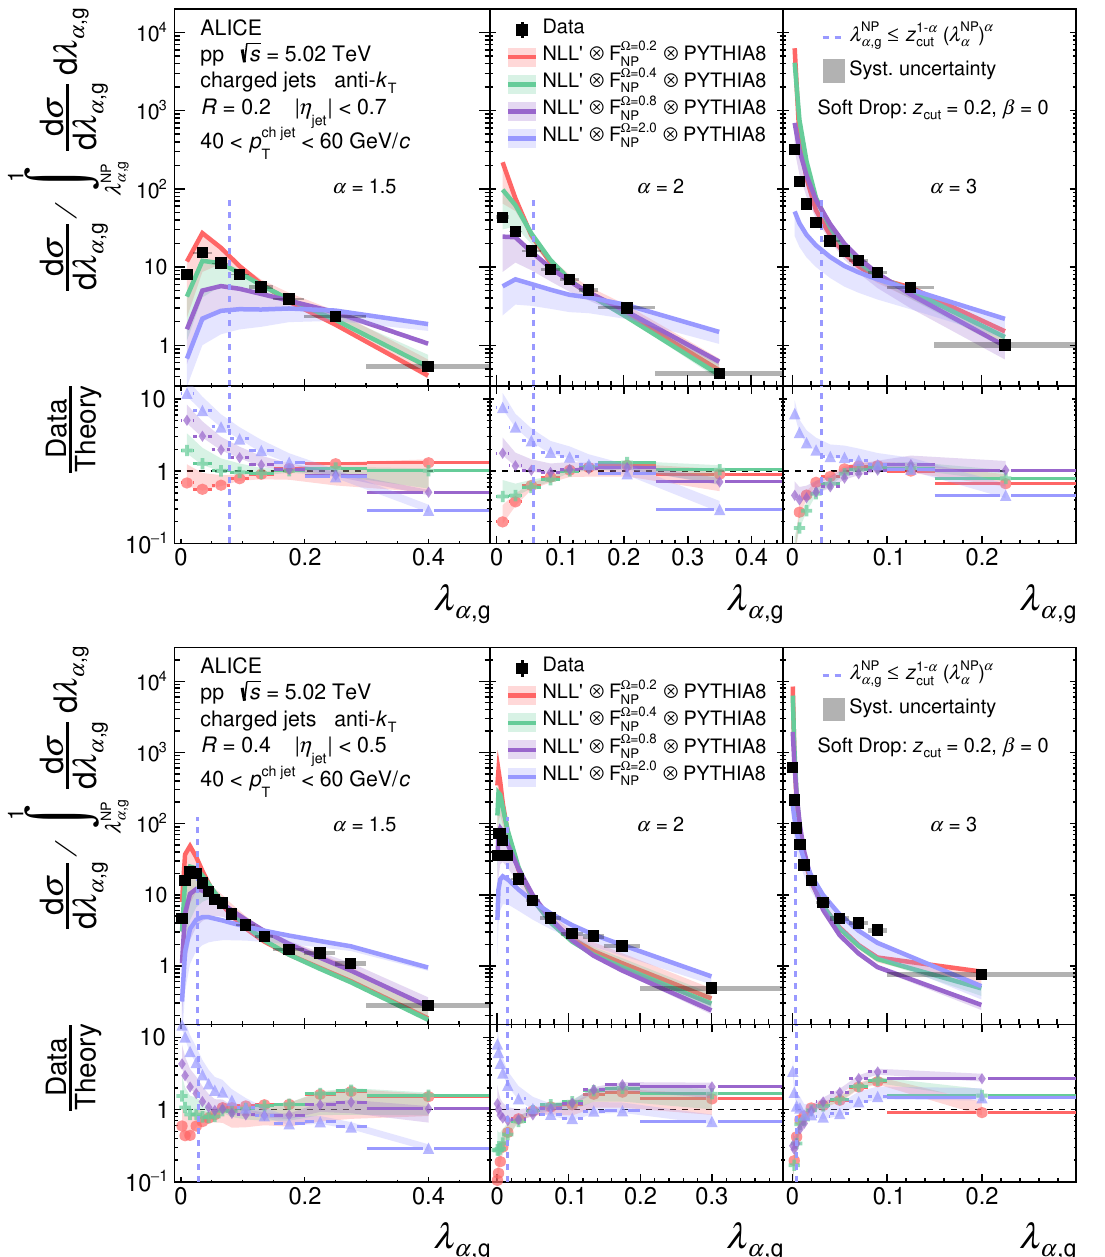
Figure 13 . Comparison of groomed jet angularities λ α, g in pp collisions for R = 0 . 2 (top) and R = 0 . 4 (bottom) to analytical NLL 0 predictions using F ( k ) convolution in the range 40 < p ch jet GeV /c . The distributions are normalized such that the integral of the perturbative region defined by λ α, g > λ NP (to the right of the dashed vertical line) is unity. Divided bins are placed into the α, g left (NP)